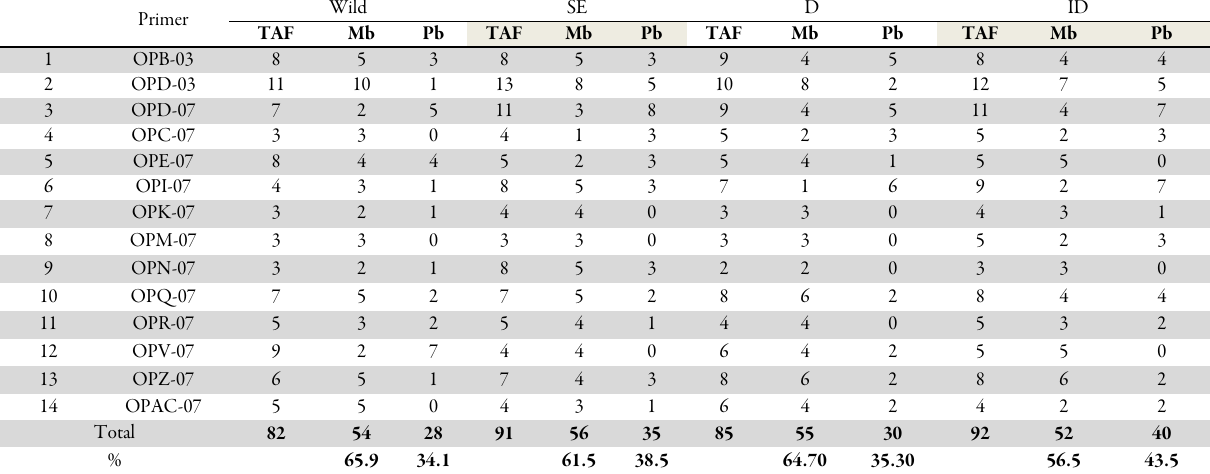
Table 2. RAPD analysis within W=Wild, SE= Somatic embryogenesis, D= Direct regeneration and ID = Indirect regeneration genotypes.TAF= Total amplified fragments, Mb= Monomorphic bands, Pb= Polymorphic bands